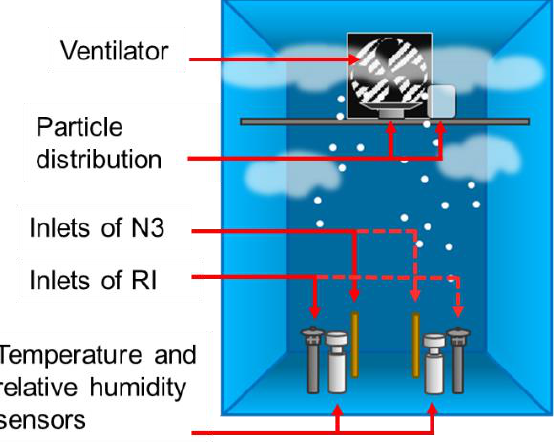
Figure 7. Test chamber configuration for the experiments with synthetic